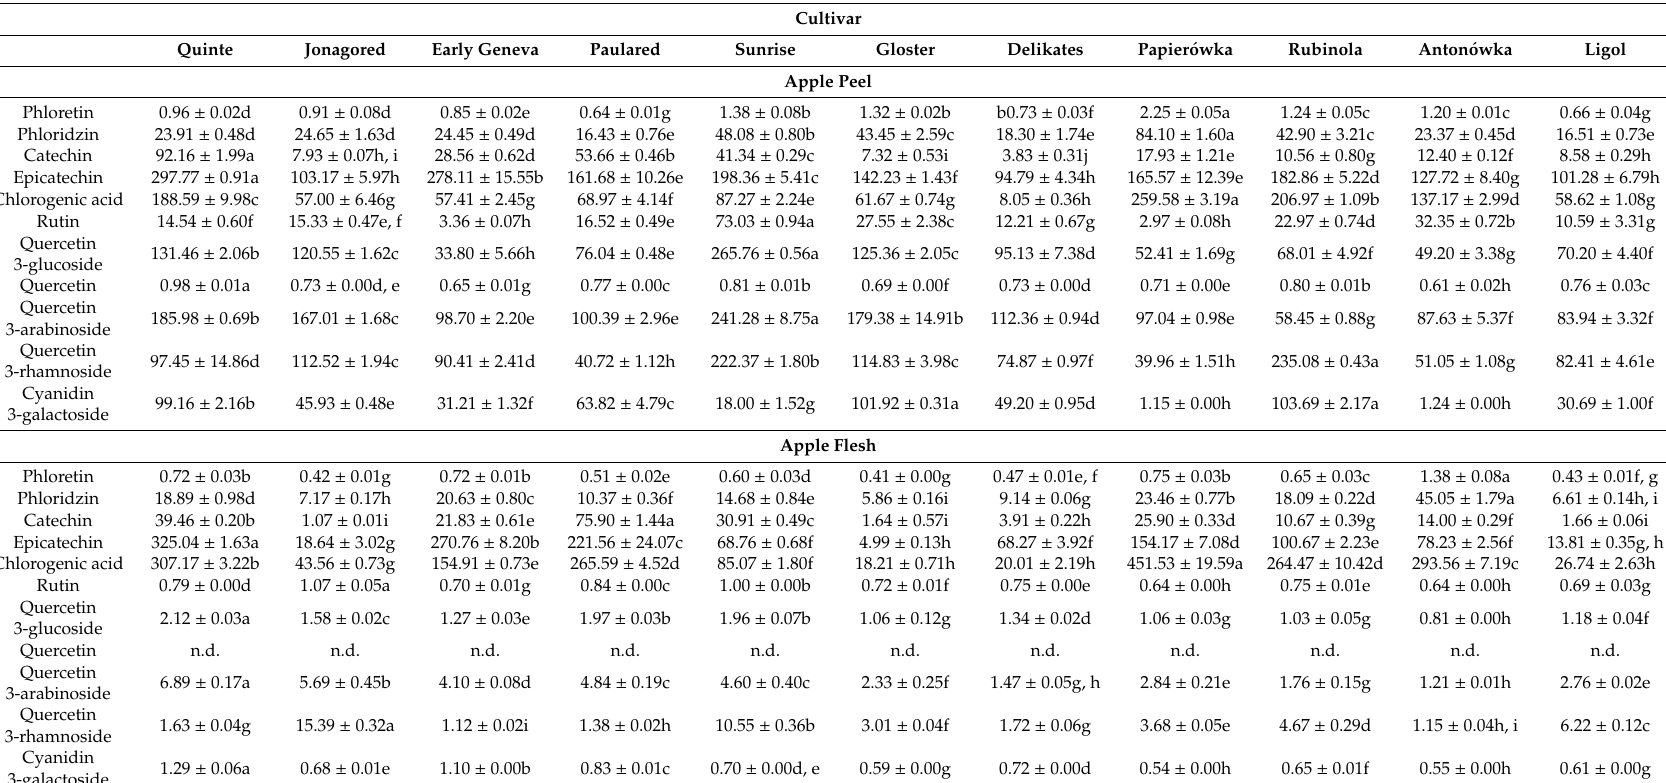
Table 3. Concentrations of the individual phenolic compounds identified by the HPLC–DAD–MS / MS analysis in the apple peel and flesh in di ff erent